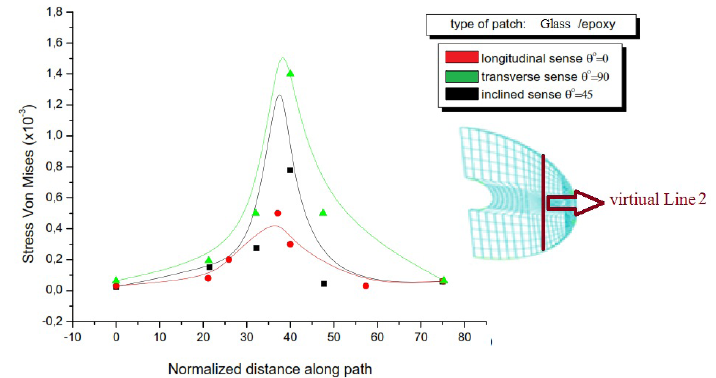
Figure 9. Distribution of σyy stresses for a cracked